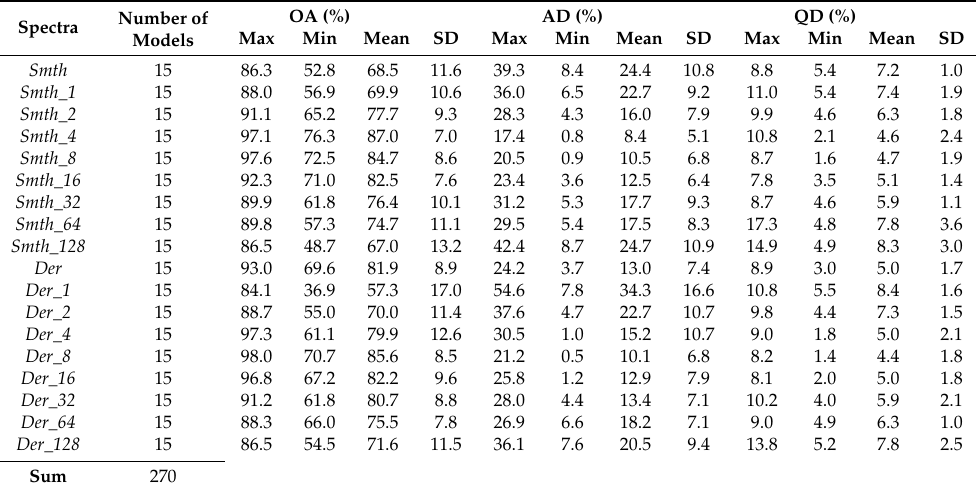
Table 3. The overall accuracies (OAs), allocation disagreements (ADs), and quantity disagreements (QDs) of models with reflectance, derivative, and wavelet power spectra.